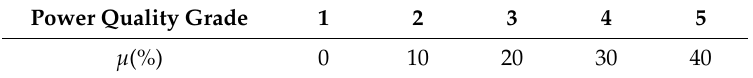
Table 2. Adjustment coefficients corresponding to different power quality grades.